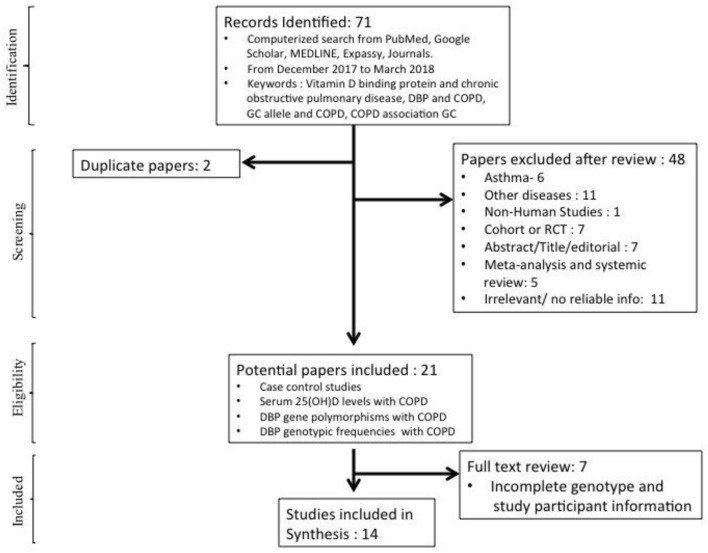
Step-wise flow chart showing identification and screening of studies included in the meta-analysis.